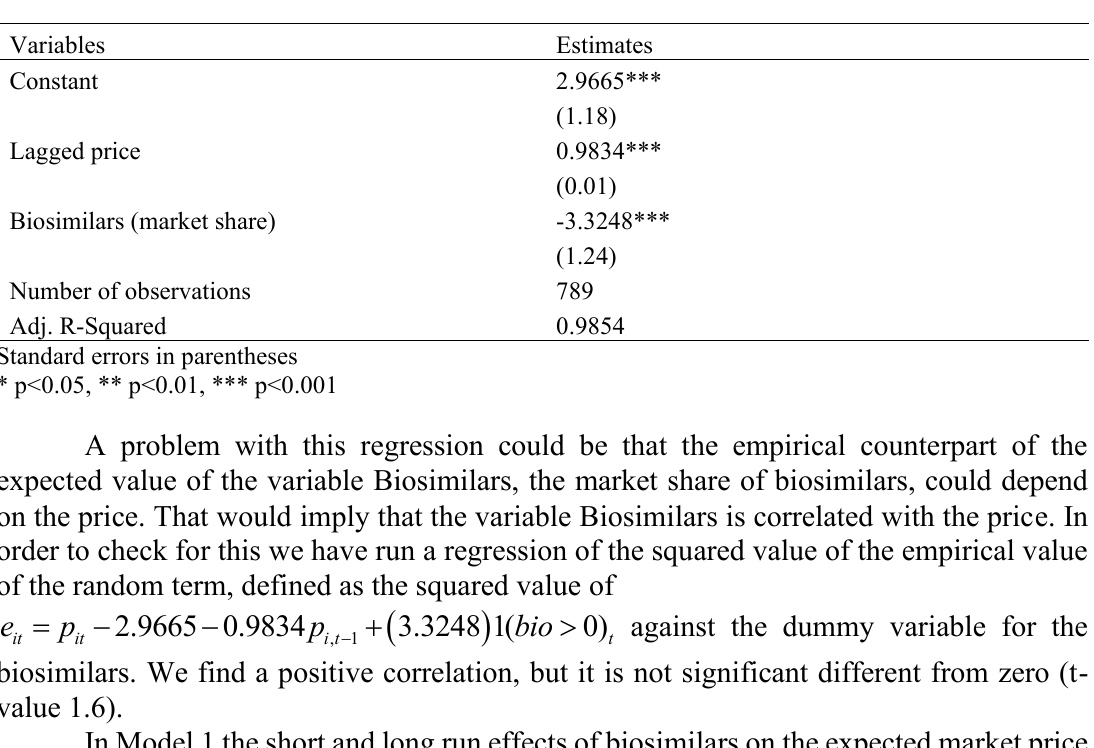
Table 2: Estimates - model